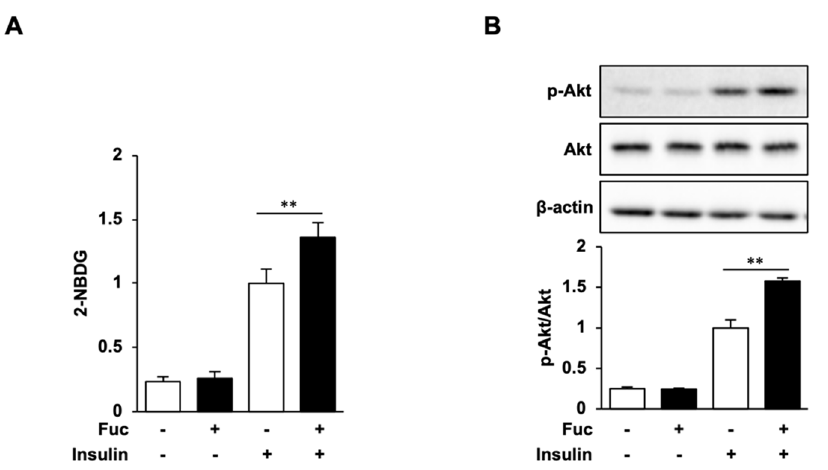
Figure 4. Effects of L ‐ fucose (Fuc) on glucose uptake and Akt phosphorylation. ( A , B ) Adipocytes treated with Fuc for 24 h were stimulated with insulin for 30 min. To estimate the glucose uptake, adipocytes were stimulated with 2 ‐ NBDG and insulin for 30 min. Data are presented as mean ± SD ( n = 3), and statistical significance was calculated using Welch’s t ‐ test (control vs. Fuc, CC vs. Fuc + CC, ** p < 0.01).